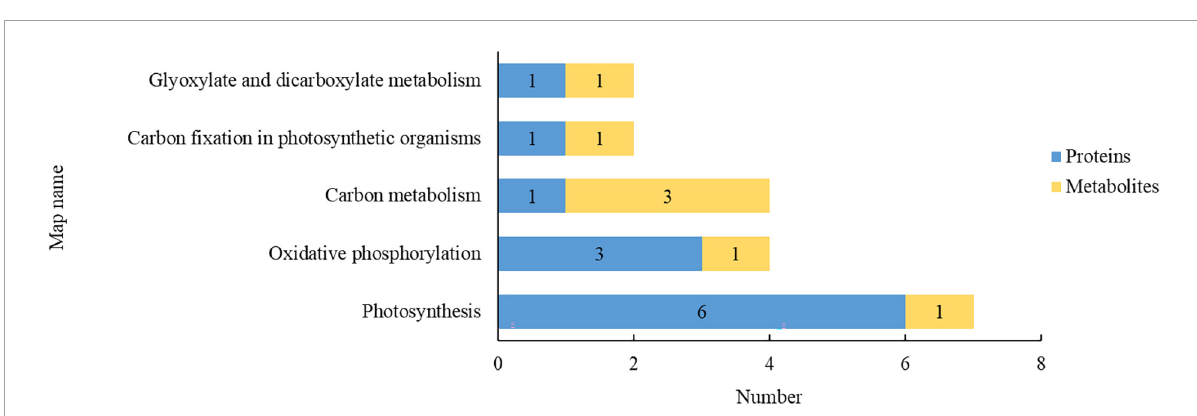
FIGURE5 Pathways involving both differentially expressed proteins (DEPs) and differentially expressed metabolites (DEMs). Blue and yellow indicate the number of DEPs and DEMs involved,